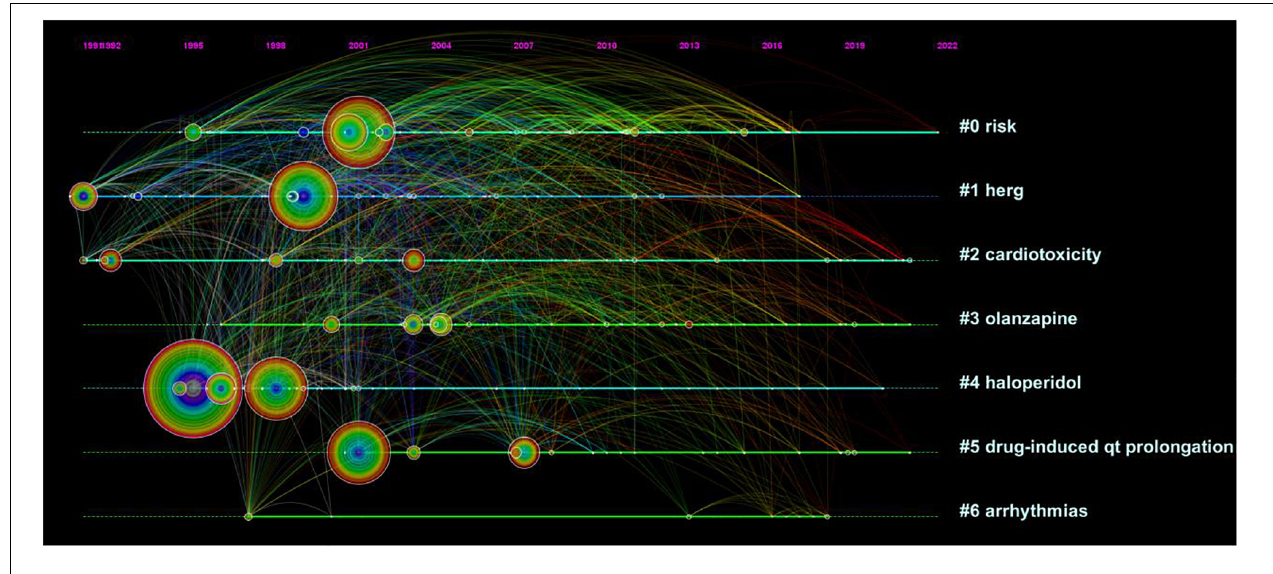
FIGURE 5 | Keyword timeline view.